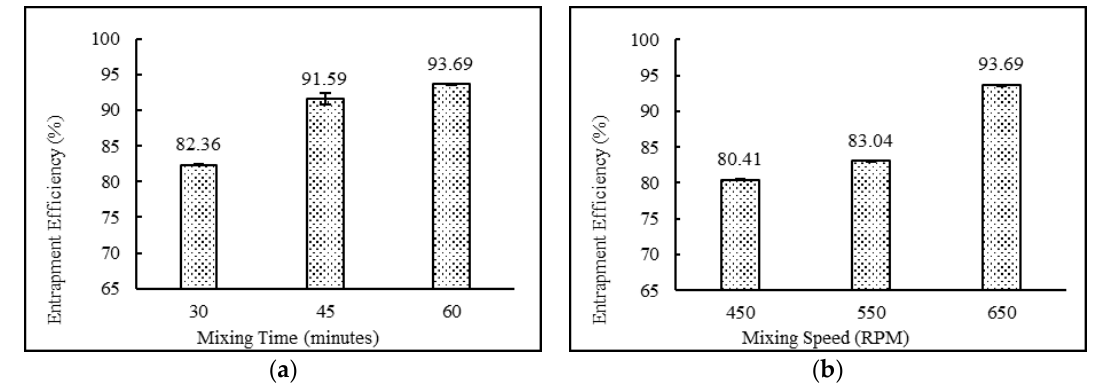
Figure 4. Effect of ( a ) mixing time (minutes) and ( b ) mixing speed (rpm) on entrapment efficiency (%) Figure 4. E ff ect of ( a ) mixing time (minutes) and ( b ) mixing speed (rpm) on entrapment e ffi ciency (%) of niosomes. ( N = 3, mean ± SD). of niosomes. ( N = 3, mean ±